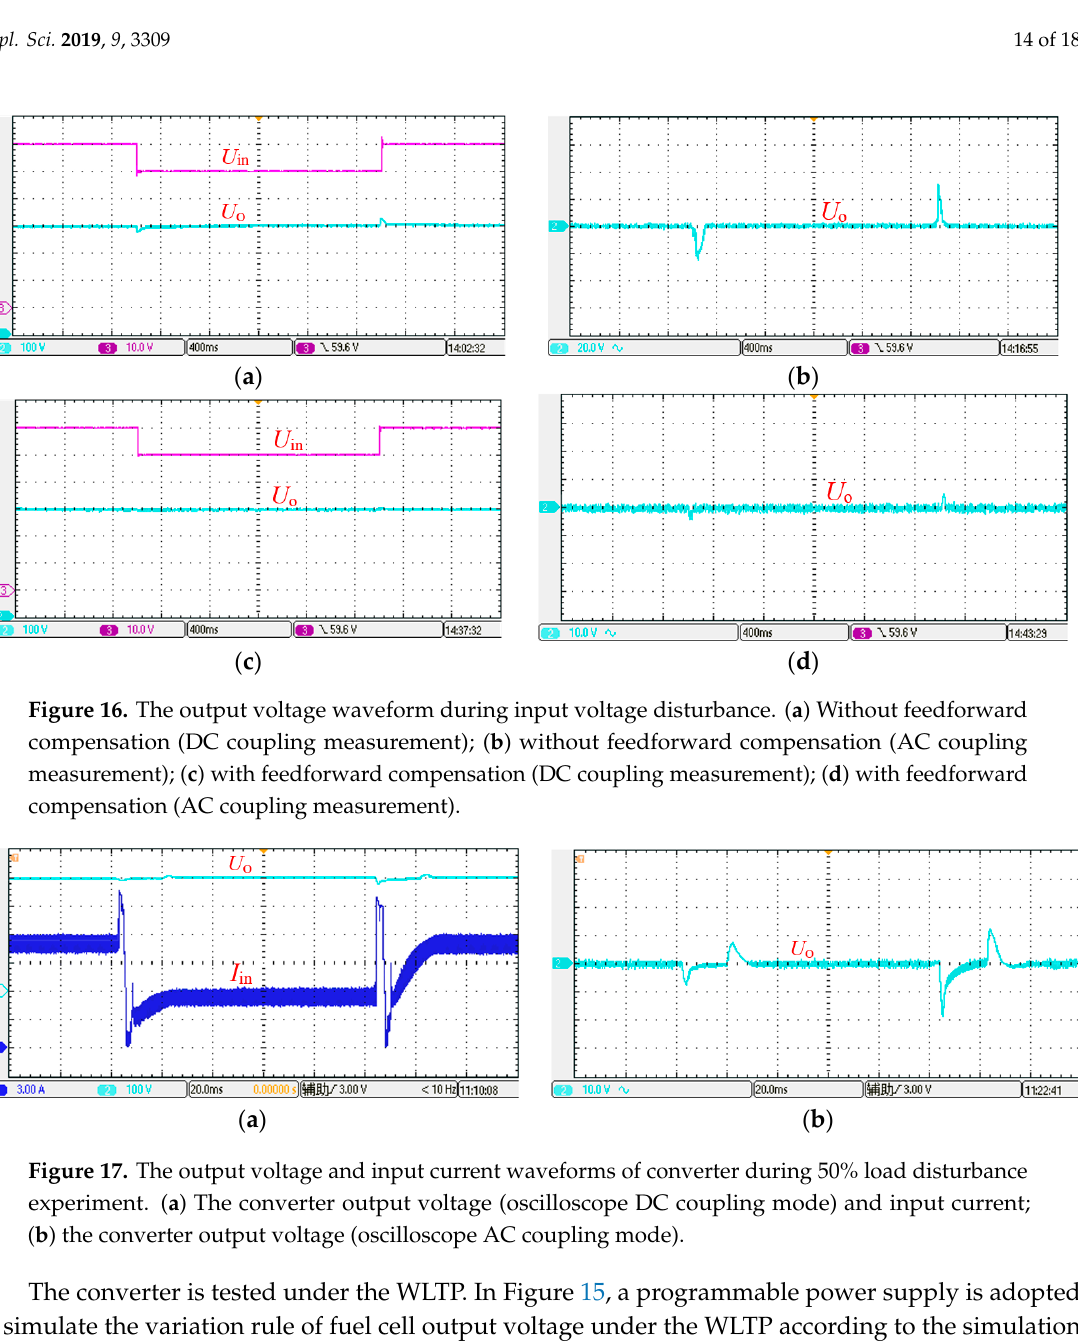
Figure 15. The experiment platform.